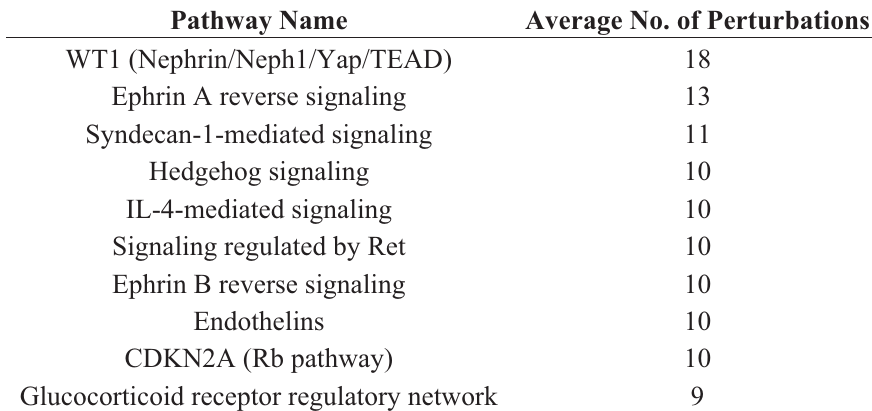
Table 1. Malignant pleural mesothelioma (MPM) specific pathway perturbations reported in The Cancer Genome Atlas